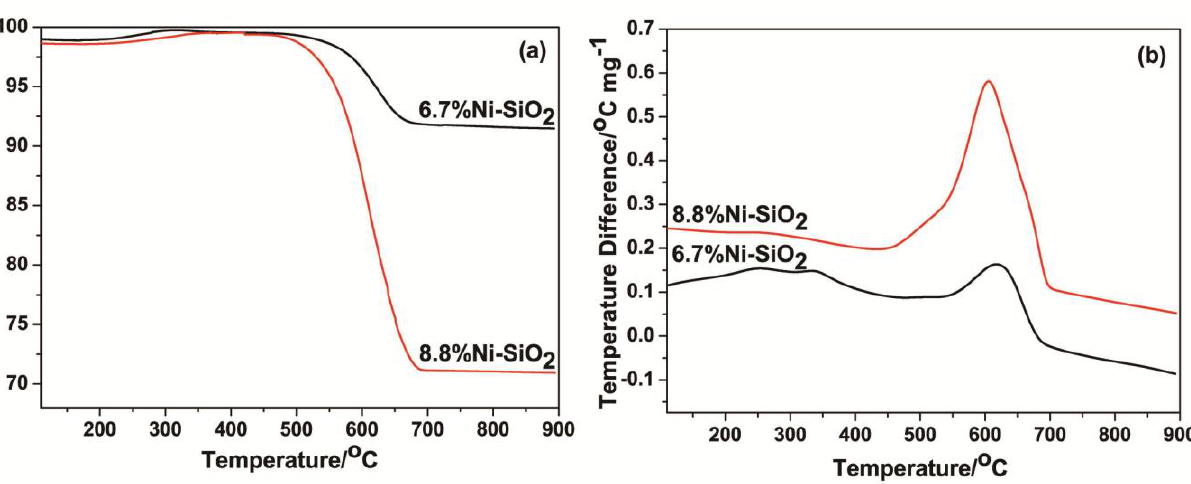
Table 2. Binding energies of Ni 2p